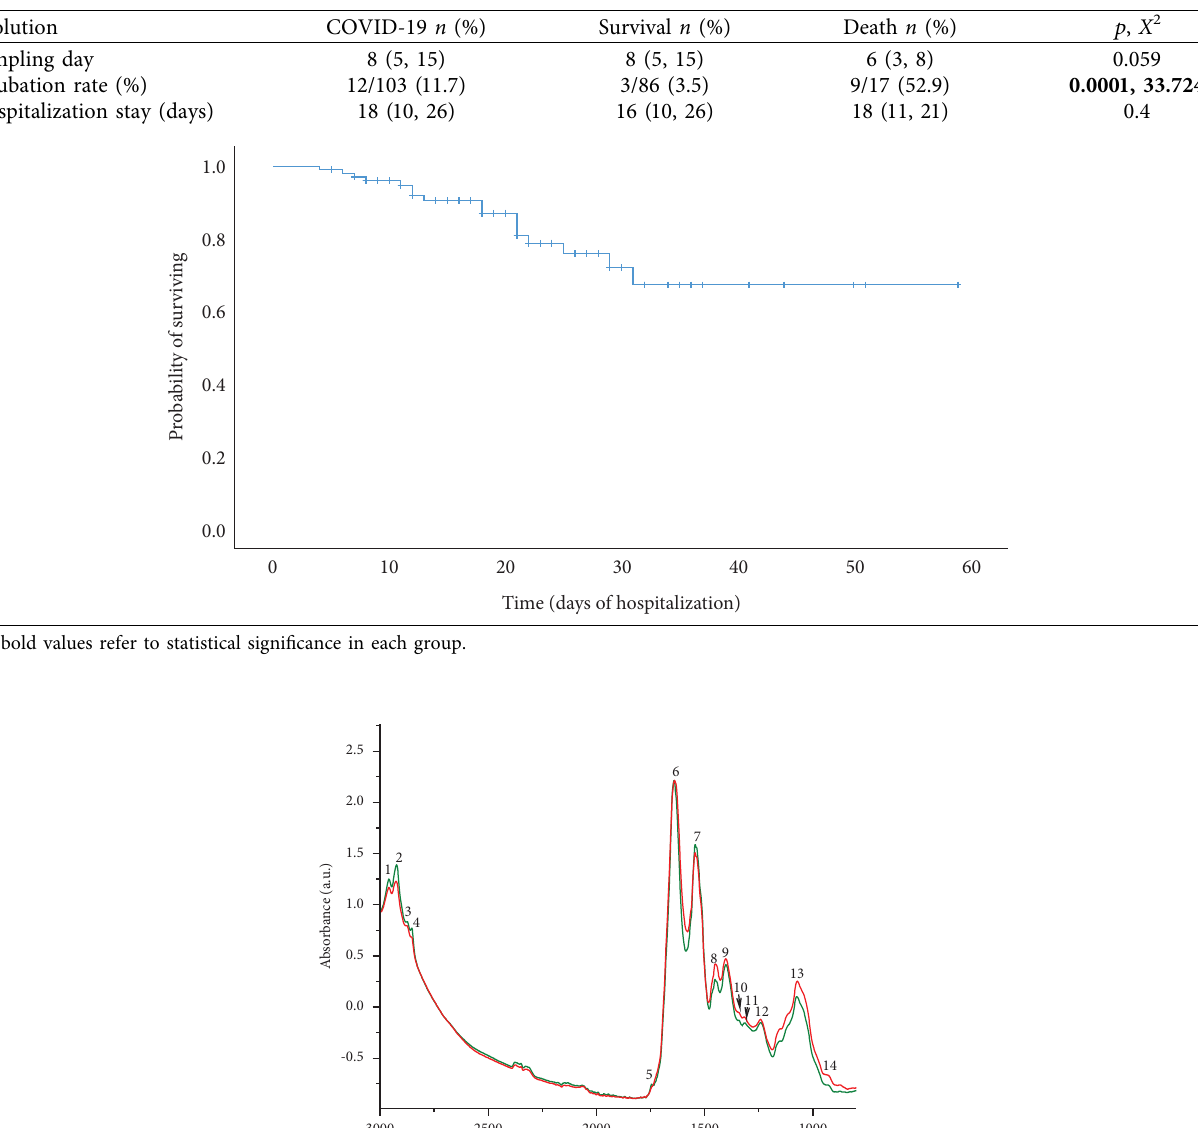
Table 3: Evolution of